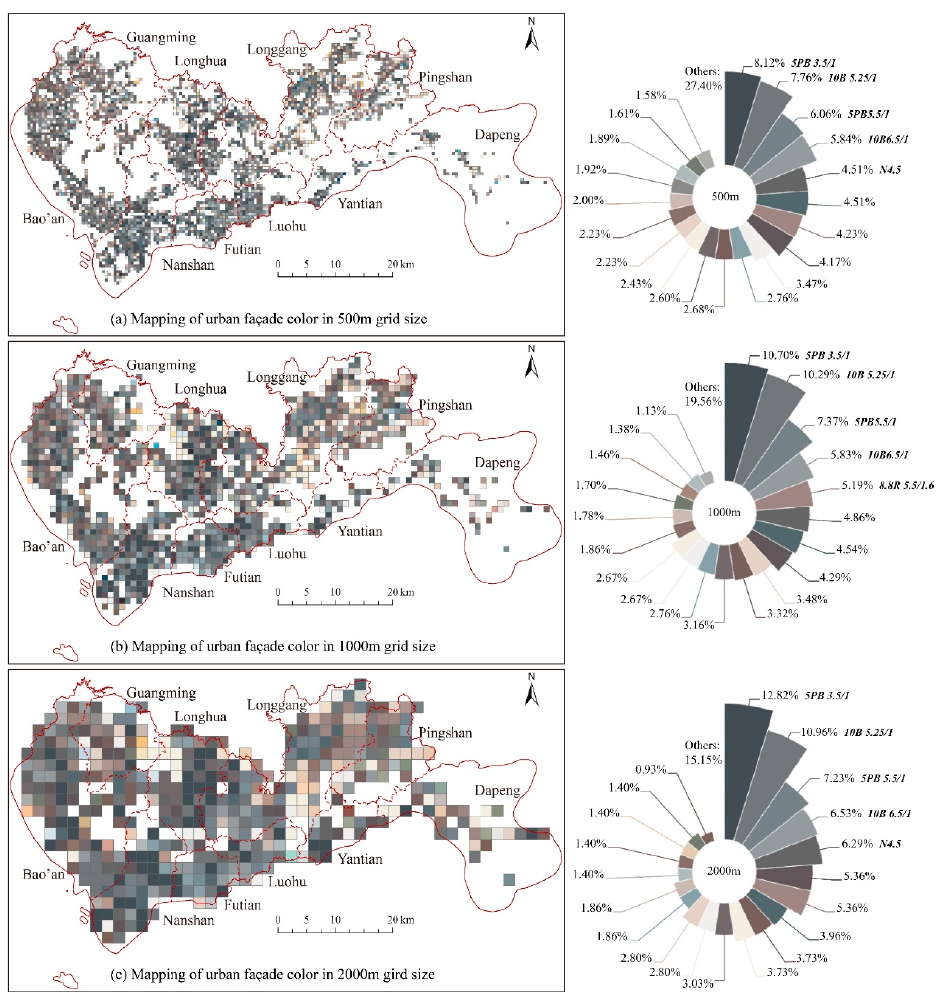
Figure 9. Comparison of mapping urban façade color of Shenzhen in different grid size. As shown in Figure 9, the dark-gray color (Munsell code: 5PB 3.5/1) is the urban fa- çade color with the largest proportion in all three grid sizes. In the grid-scale of 500 m (Figure 9a), the urban façade color of Shenzhen is a gray tone, together with some bright and high chroma tones such as red, blue, and green. The bright colors are the various façade colors of some hotels or commercial buildings. Some commercial buildings have adopted intense and jumping colors, which are in sharp contrast with office buildings. As the grid size increases, the detailed color information in small unit sizes is integrated. At the grid-scale of 2000 m (Figure 9c), the dark-gray color is distributed in patches, and mainly distributed in Nanshan District, and Longhua District. Brown and brown– gray colors are concentrated in Longgang District, Pingshan District, and Dapeng District, but rarely appear in Nanshan District, Futian District, and Luohu District. Light yellow is occasionally distributed in Longgang District, Pingshan District, and Longhua District. Overall, the colors are more diverse and brighter in Longgang District, Pingshan District, and Dapeng District than in Nanshan District, Futian District, and Luohu District.